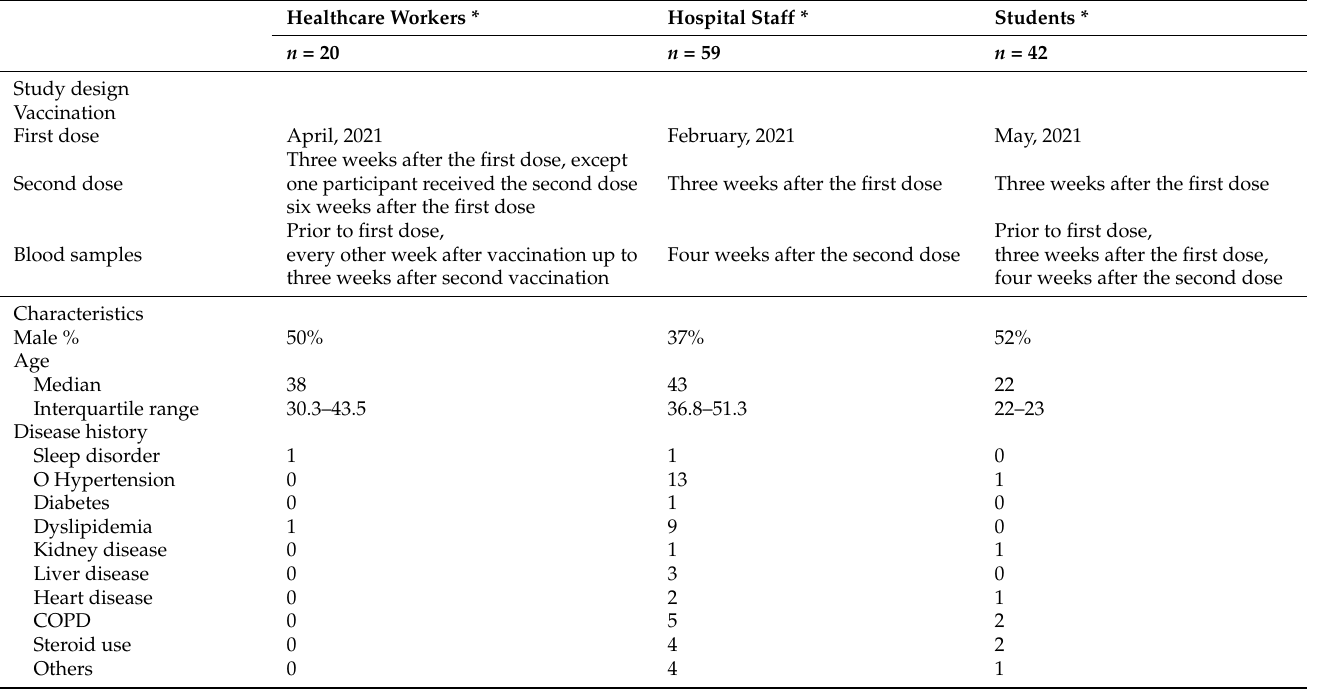
Table 1. Study design and characteristics of